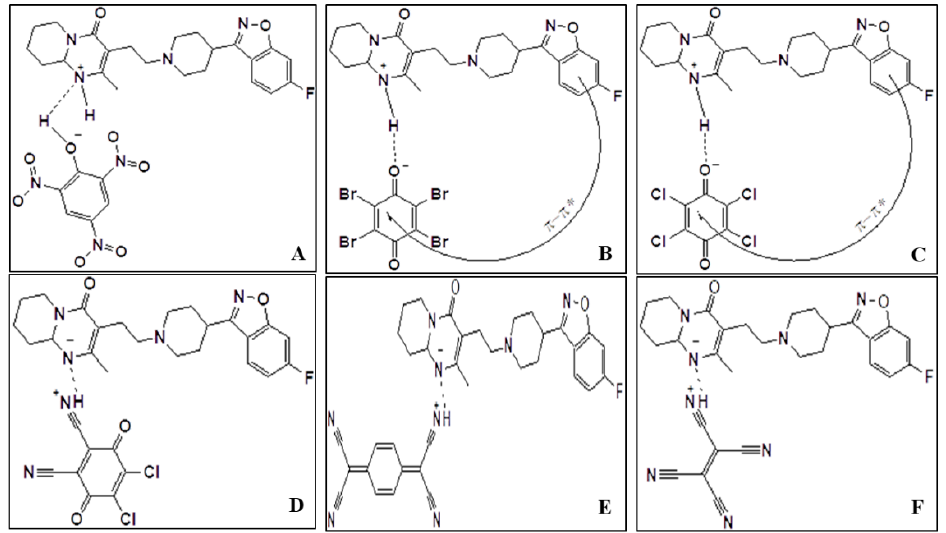
Figure 2. Speculated formula of Ris-PA ( A ), Ris-BL ( B ), Ris-p-CL ( C ), Ris-DDQ ( D ), Ris-TCNQ ( E ), and Ris-TCNE ( F ) charge transfer complexes.